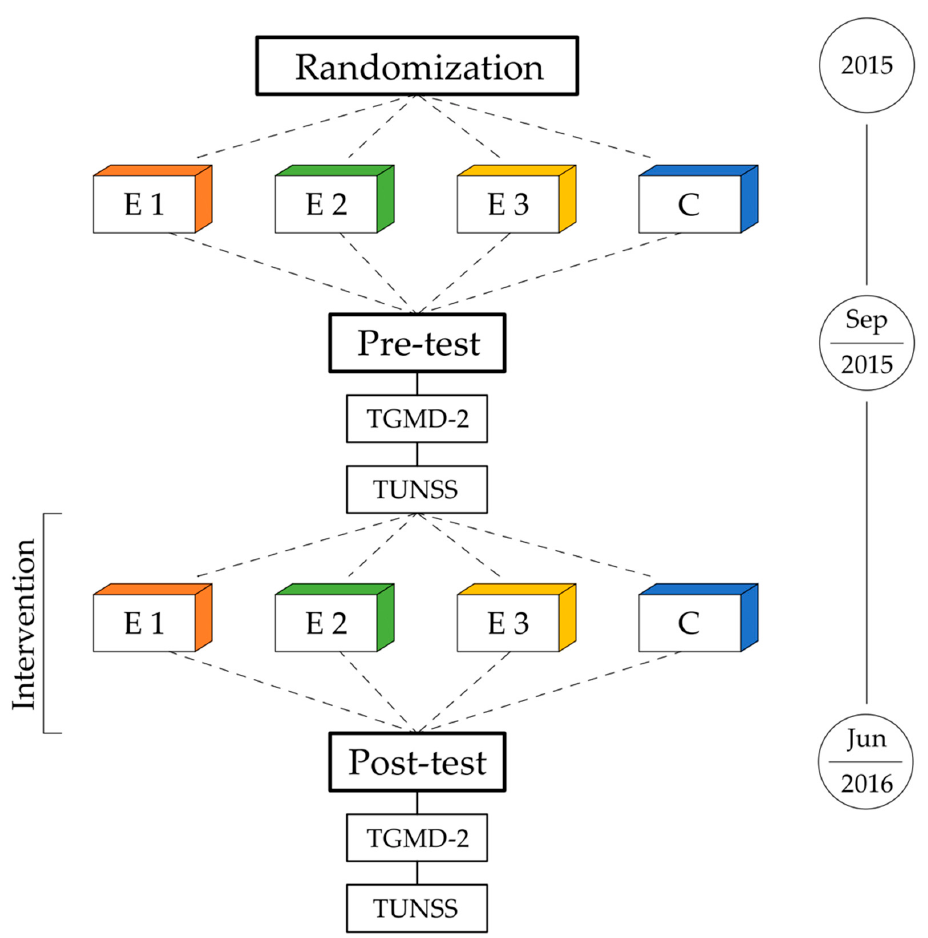
Figure 2. Schematic depicting the experimental workflow. Classes were randomly assigned into experimental (E1, E2, and E3) and control (C) groups. Pre-test was carried out as follows: (1) Test of Gross Motor Development (Second Edition) and (2) Test of School Start Skills. PE classes in C and E1 were conducted by a classroom teacher, while in E2 by a physical education teacher, and in E3 by both of them in cooperation. Post-test was carried out in the same order as pre-test.